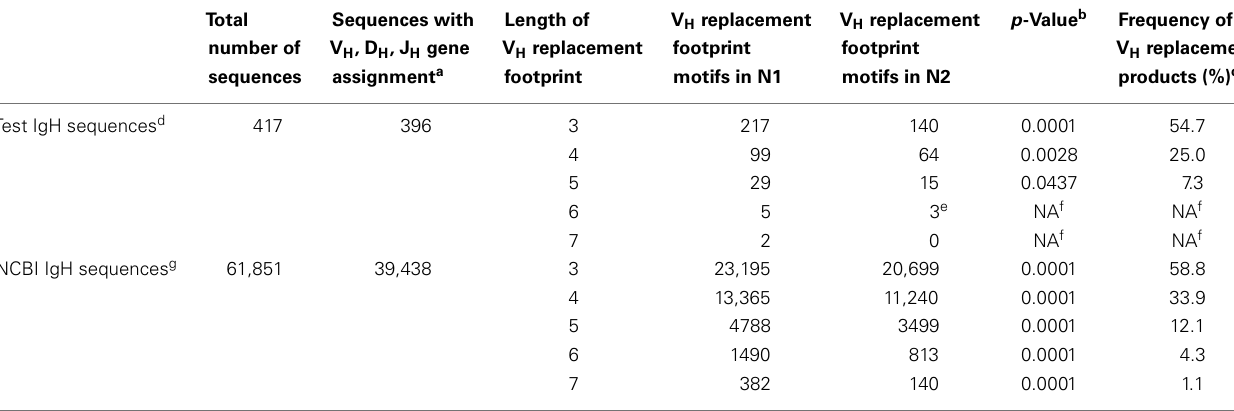
Table 1 | Frequencies ofV H replacement footprint motifs in the N1 and N2 regions of human IgH genes